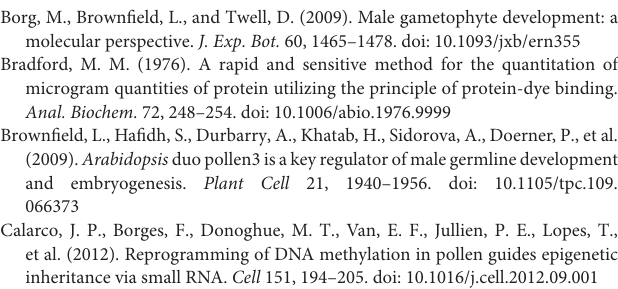
Supplementary Figure 1 | Diagram of the experimental procedure. Supplementary Figure 2 | The chromatogram of the peptide mixture fractionated by high-pH reversed-phase chromatography. Supplementary Figure 3 | The PPI network of other DAPs highly expressed in VN and GN. Supplementary Figure 4 | The metabolism network of 57 DAPs highly expressed in VN using STRING. Supplementary Table 1 | The summary of MS result. Supplementary Table 2 | Detailed information of 720 DAPs identified by mass spectrometry. Supplementary Table 3 | The functional categories of the 720 DAPs. Supplementary Table 4 | The list of identified transcription